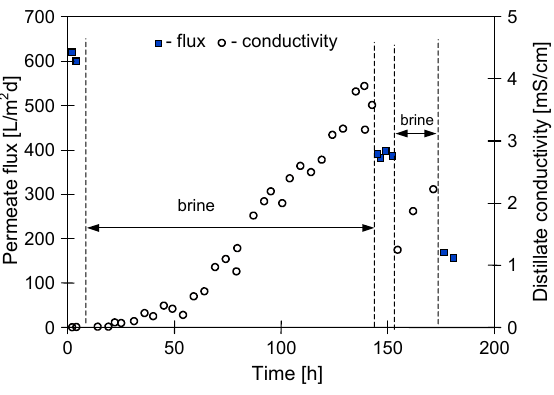
Figure 6. Changes of the maximal permeate flux (feed 10 g NaCl/L) and distillate electrical conductivity during MD of NaCl saturated solutions. Module MD2.